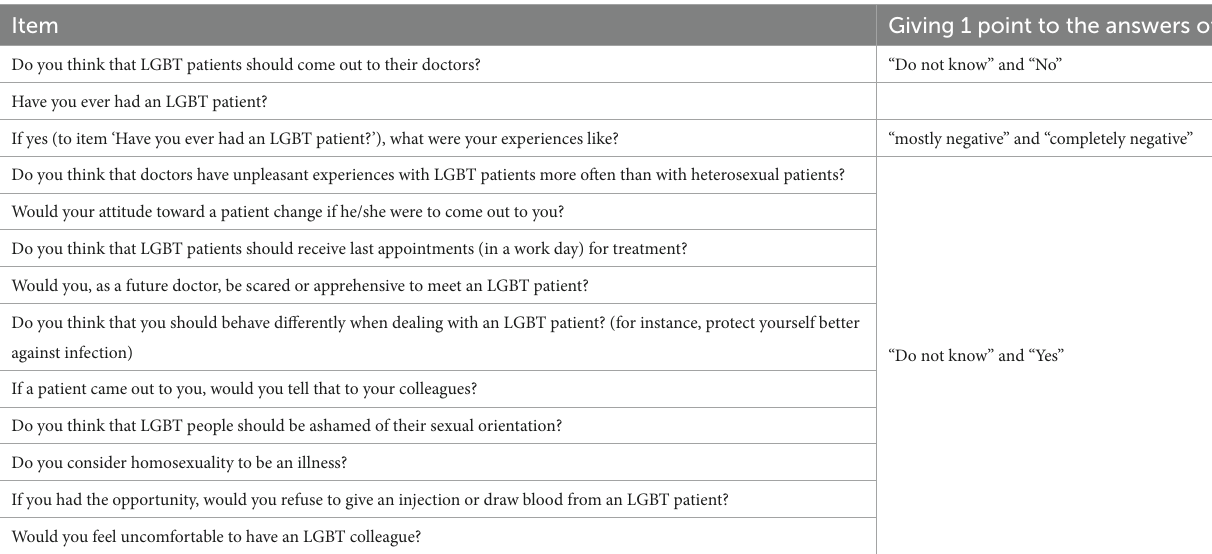
TABLE 3 Professional homophobic attitude